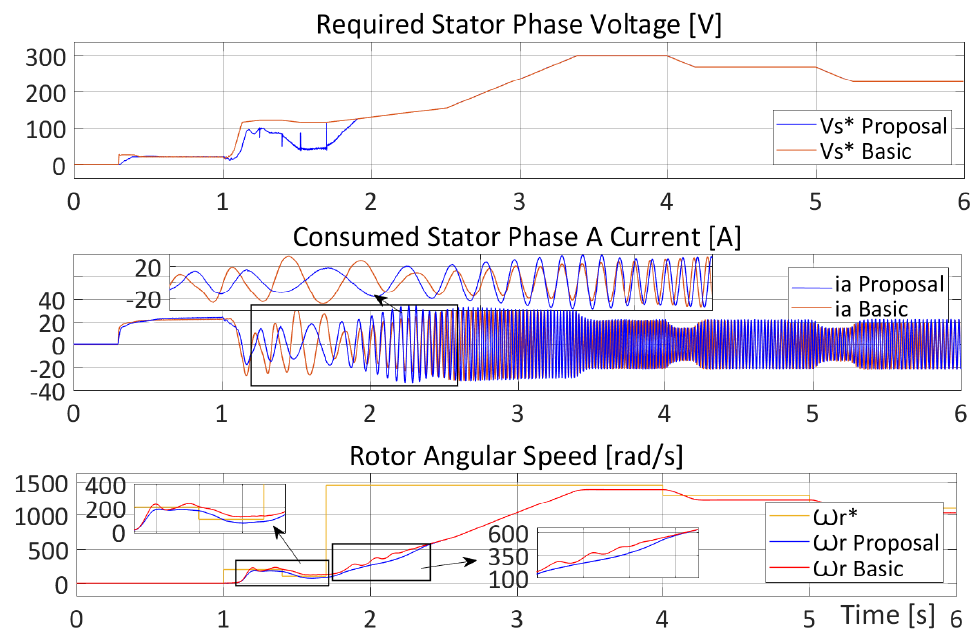
Figure 7. Compararative OPAL-RT waveforms of voltage, current, and rotor angular